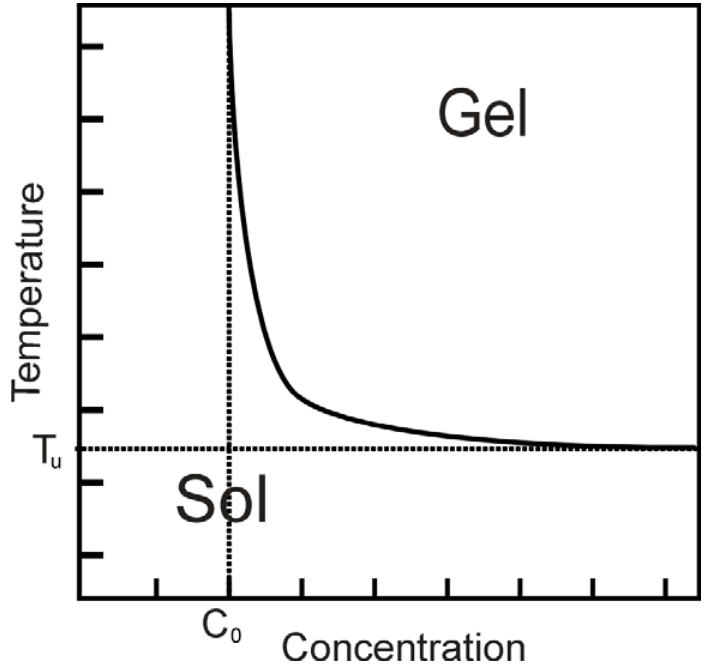
FIGURE 8 . Temperature vs. concentration in the lower critical solution temperature (LCST) type phase